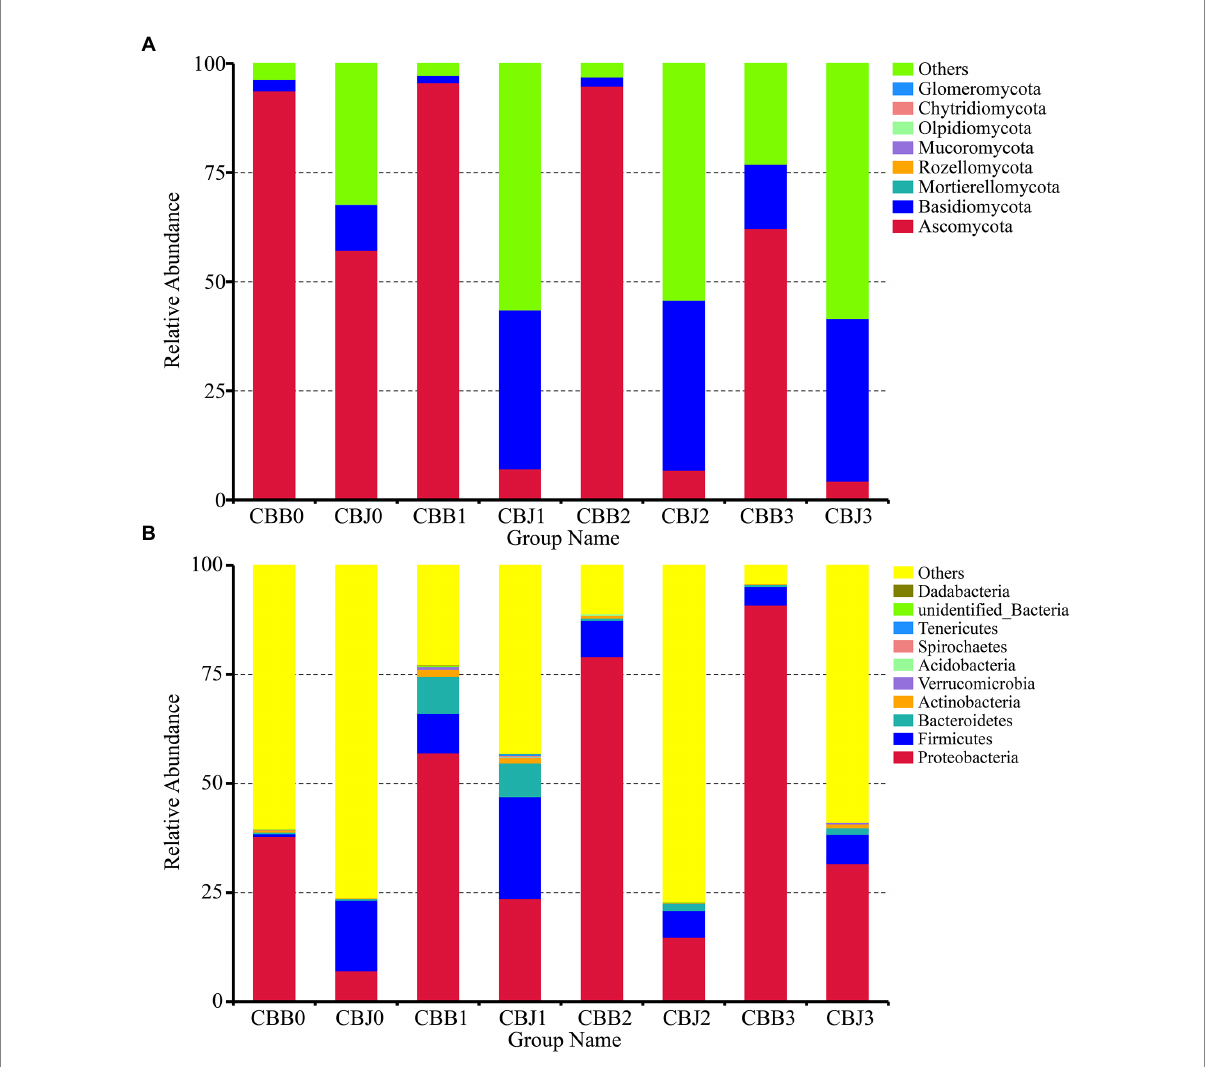
FIGURE 1 Microbial community composition of symptomatic (CBB) and asymptomatic (CBJ) tobacco leaves at four sampling time points (0–3) at the phylum levels ( A for fungi, B for bacteria). The phyla with relative abundance less than 0.01% or without identification were classified as